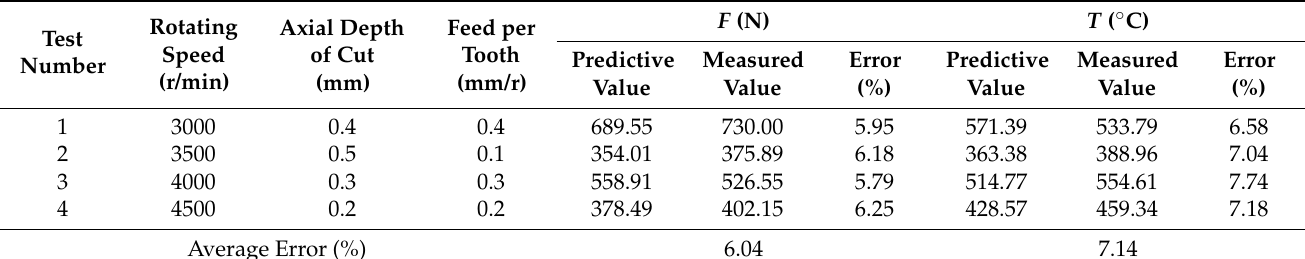
Table 5. Comparison of predicted and measured